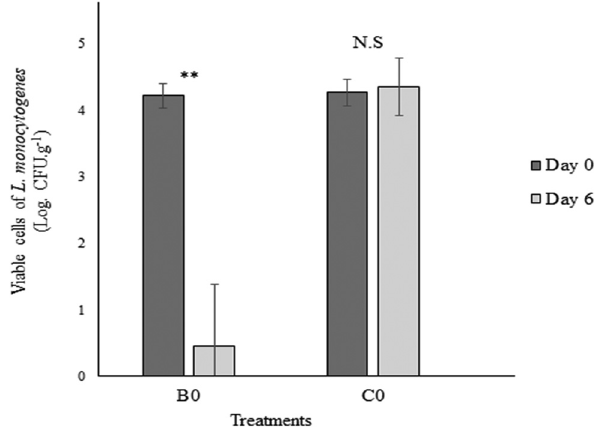
Figure 3: Viability of L. monocytogenes in Atlantic salmon fi llets after immersion in BLIS liquid and stored at 0°C. B0 was salmon fi llets immersed in BLIS, inoculated with L. monocytogenes, and incubated at 0°C, C0 was a control in which the salmon fi llets were immersed in sterile MRS broth prior to inoculation. ** represents a signi fi cant di ff erence between TVC at day 0 and after 6 days stored at 0°C ( p < 0.05 )